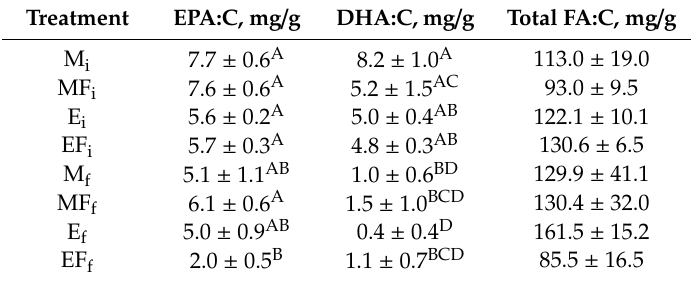
Table 3. Results of one-way ANOVA comparing means ( ± SE) of content per organic carbon (C) of indicators of nutritive quality of seston in experimental mesocosms: EPA—eicosapentaenoic